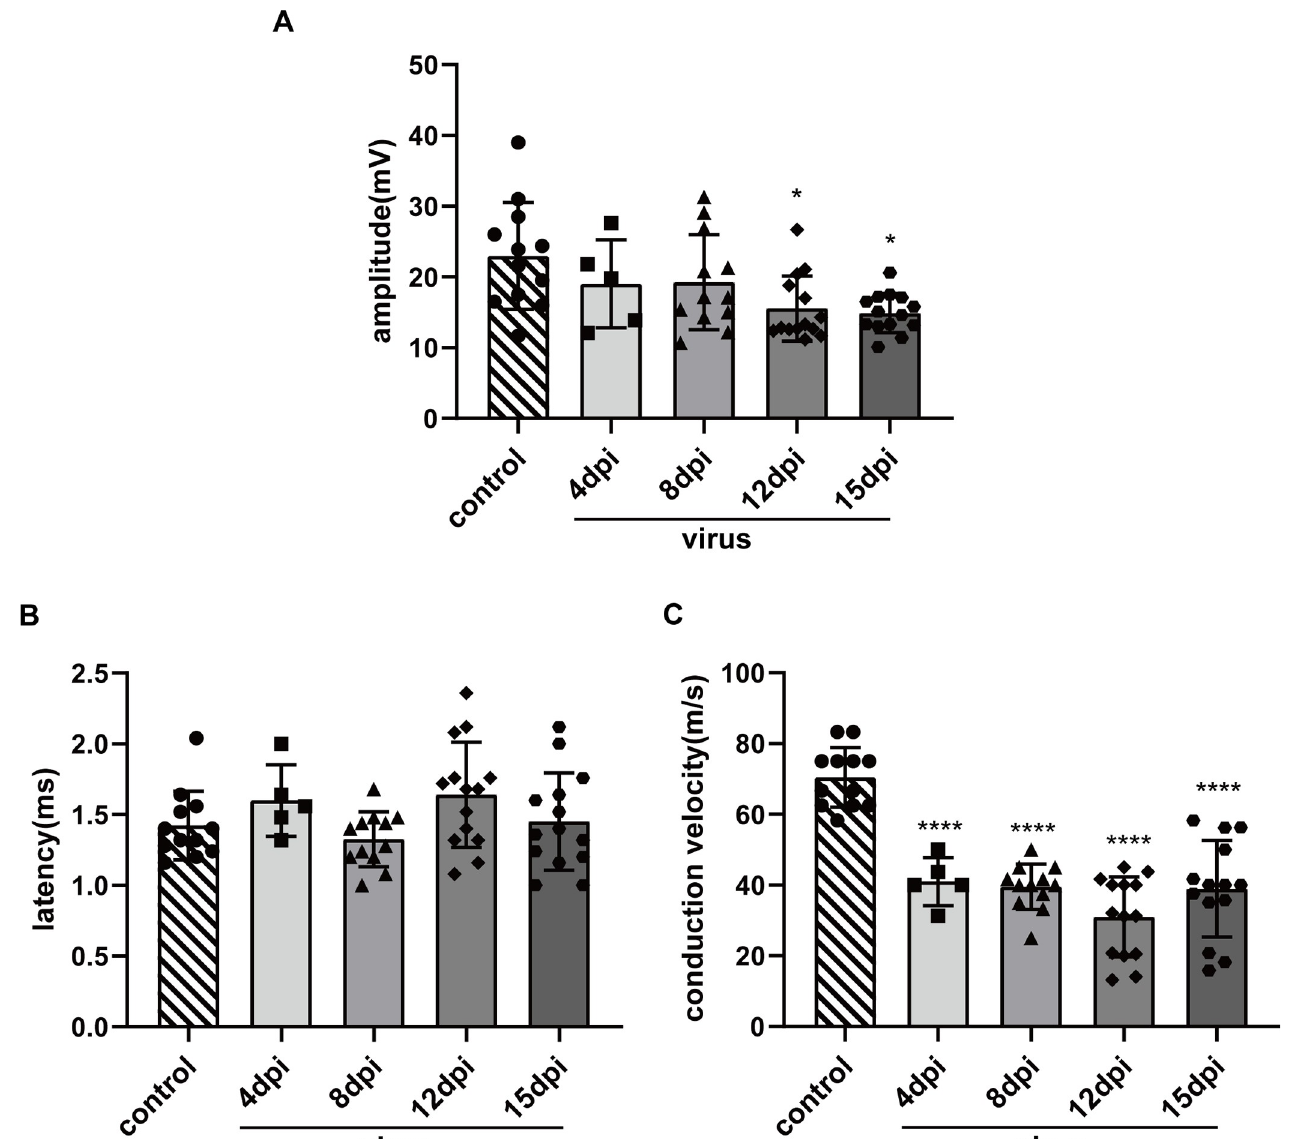
Fig 2. CMAP assessment of the sciatic nerve in mice. (A) Amplitude. Kruskal-Wallis H test was used ( � P = 0.0173); (B) End latency. One-way ANOVA was used (P = 0.0903); (C) Conduction velocity. Statistical analysis by one-way ANOVA ( ���� P < 0.0001).